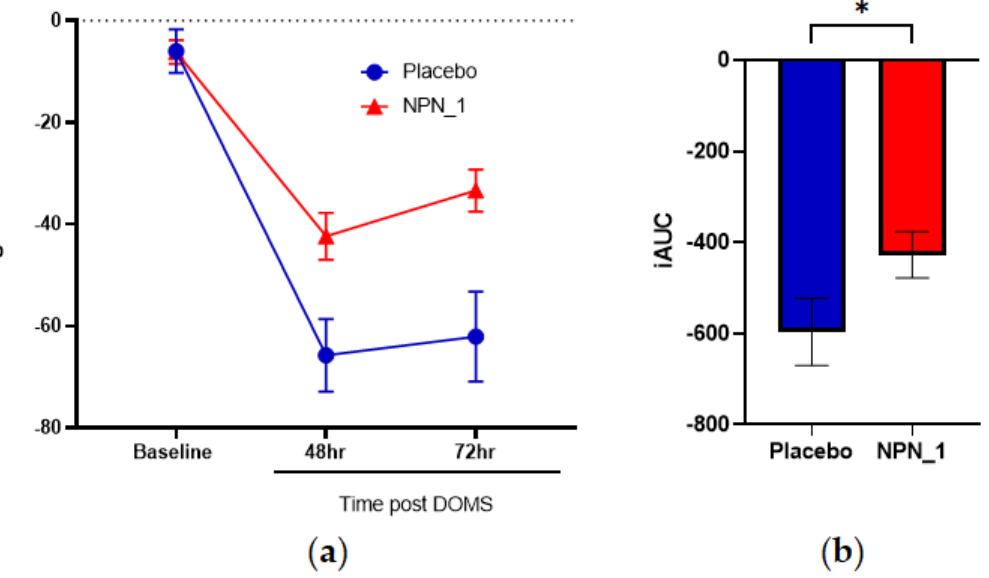
Figure 4. NPN_1 significantly relieves fatigue and allows a return to performance. ( a ) Fatigue index was calculated between sets at each strength measurement timepoint (mean ± SEM, RM-ANOVA, p = 0.002) and expressed over time. Significant effects were also observed at individual time points of 48 h. ( b ) iAUC of fatigue index was calculated over the study duration (mean ± SEM, Mann–Whitney, p = 0.041, * p < 0.05).